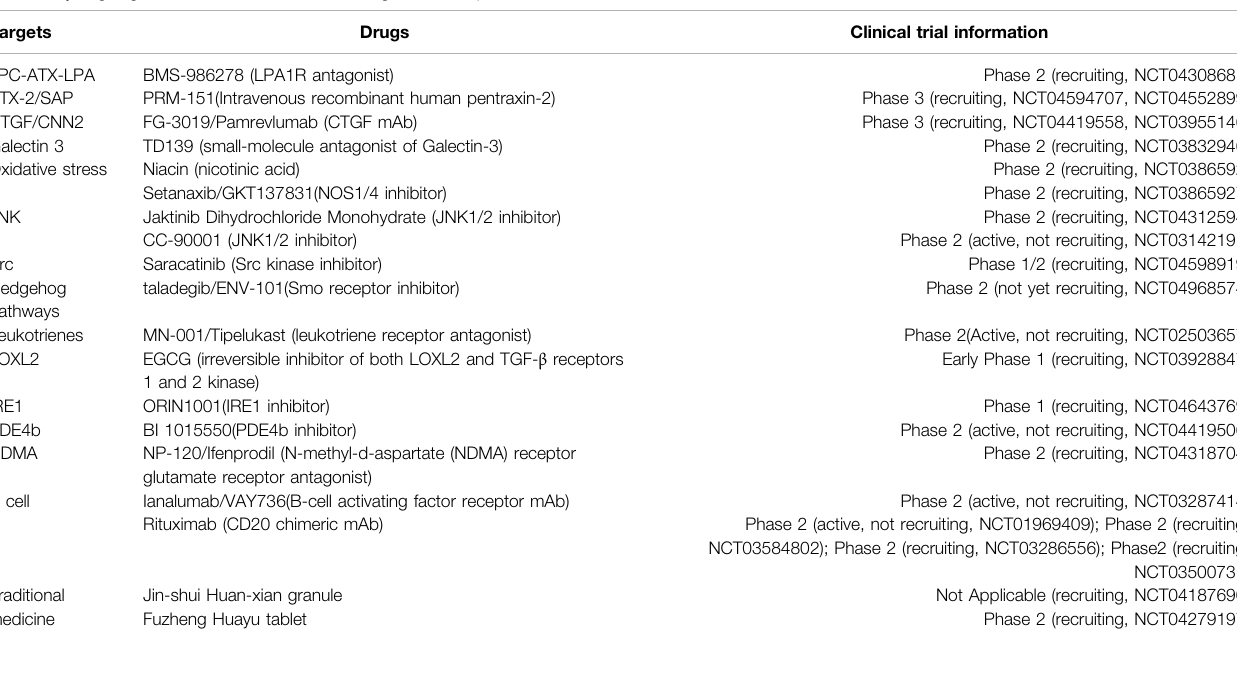
TABLE 5 | Ongoing clinical trials about some investigational compounds for